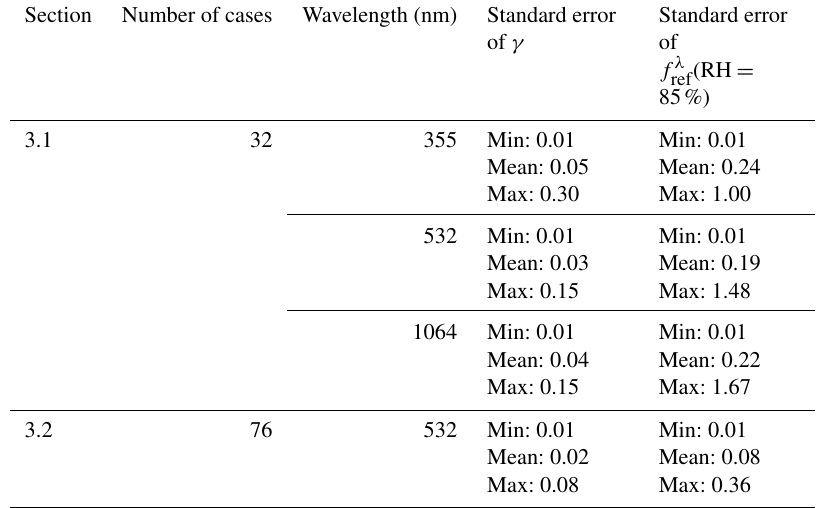
Table 1. Minimum, mean and maximum standard errors of γ and f λ Section Number of cases Wavelength (nm) Standard error